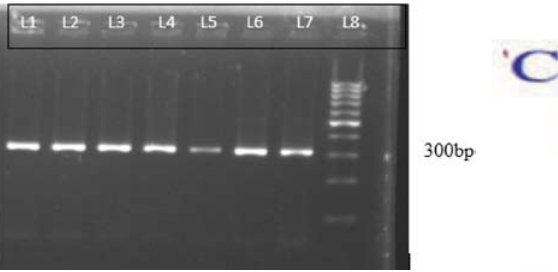
Fig. 1. PCR amplification of BRCA2 for PCR-RFLP analysis (312 bp fragment). Lane 1-7: 312 bp product Lane 8: 100 bp DNA marker